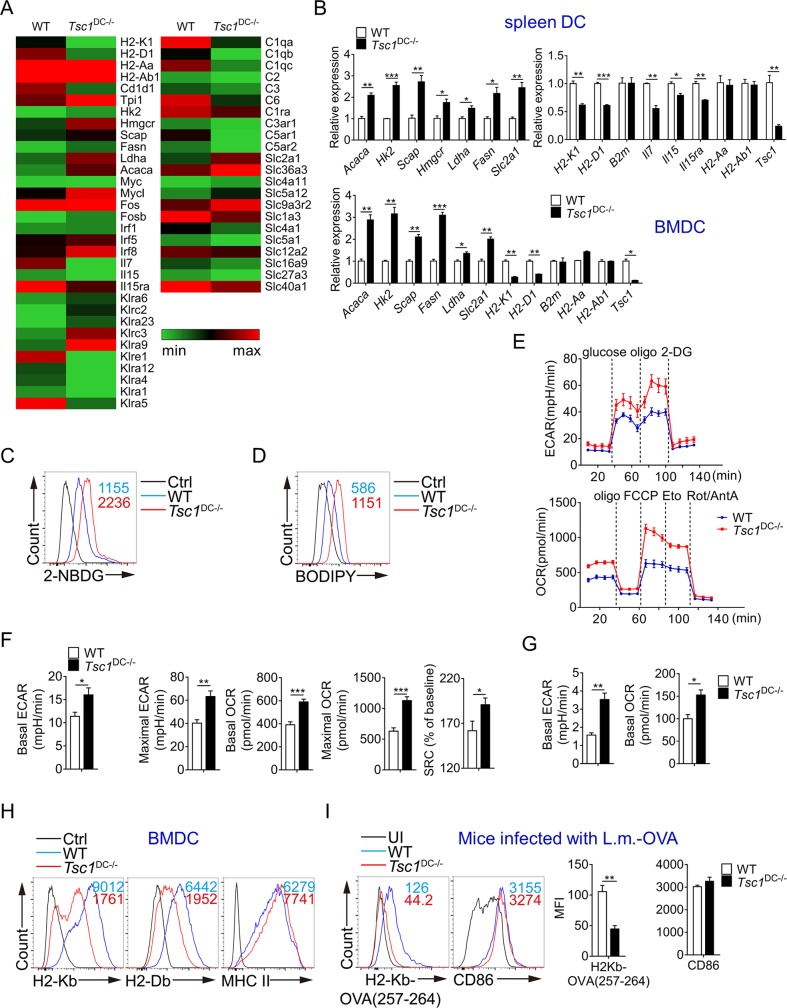
Elevated glycolysis and fatty acid synthesis in TSC1DC-KO mice.(A) Genome-wide RNA-seq analysis on spleen DCs isolated from 6–8-week-old WT and TSC1DC-KO littermates; the heat map shows differentially expressed gene sets, and the original data deposited in the Sequence Read Archive of NCBI database are accessible via accession No. PRJNA516783. (B) Real-time PCR analyses of gene expression in spleen DCs and BMDCs from 6–8-week-old WT and TSC1DC-KO littermates. These experiments were repeated twice with similar results. The data are shown as means ± SEM (*p < 0.05, **p < 0.01, ***p < 0.001; analyzed by Student’s t test). (C and D) BMDCs were incubated with 50 μM 2-NBDG for 15 minutes (C) or 5 μg/ml BODIPY for 30 minutes (D) at 37°C, and the fluorescent intensity was measured by flow cytometry. These experiments were repeated once with similar results. (E and F) Real-time changes in ECAR and OCR were analyzed in WT and TSC1DC-KO BMDCs by a Seahorse analyzer following sequential treatment with 10 mM glucose, 1 μM oligo, and 100 mM 2-DG or with 1 μM oligo, 1.5 μM FCCP, 200 μM Eto, and 100 nM Rot plus 1 μM AntA (Rot/AntA). Basal ECAR, maximal ECAR (after treatment with oligo), basal OCR, maximal OCR (after treatment with FCCP), and SRC were calculated accordingly (F). These experiments were repeated twice with similar results. The data are shown as means ± SEM (*p < 0.05, **p < 0.01, ***p < 0.001; analyzed by Student’s t test). (G) The basal ECAR and OCR of splenic DCs from WT and TSC1DC-KO mice were analyzed by a Seahorse analyzer, and this experiment was conducted twice with similar results. The data are presented as means ± SEM (*p < 0.05, **p < 0.01; analyzed by Student’s t test). (H) The cell surface MHC-I and MHC-II expression in WT and TSC1DC-KO BMDCs was analyzed by flow cytometry. This experiment was repeated once with similar results. (I) The 6–8-week-old WT and TSC1DC-KO littermates (n = 3) were i.v. infected with 105 CFU of L.M.-OVA, and the expression levels of cell surface H2-Kb/OVA257-264 complexes and CD86 in splenic DCs (gated on CD11c+MHC-II+) were analyzed by flow cytometry after 3 days. This experiment was repeated once with similar results. MFI are presented as means ± SEM (**p < 0.01, analyzed by Student’s t test). Underlying data are available in S1 Data. 2-DG, 2-deoxy-D-glucose; 2-NBDG, 2-deoxy-2-[(7-nitro-2,1,3-benzoxadiazol-4-yl)amino]-D-glucose; Acaca, acetyl-coenzyme A carboxylase alpha; AntA, antimycin A; B2m, beta-2 microglobulin; BMDC, bone marrow–derived DC; BODIPY, boron-dipyrromethene; CD, cluster of differentiation; CFU, colony-forming unit; Ctrl, control; DC, dendritic cell; ECAR, extracellular acidification rate; Eto, etomoxir; Fasn, fatty acid synthase; FCCP, fluoro-carbonyl cyanide phenylhydrazone; H2-Aa, histocompatibility 2, class II antigen A, alpha; H2-Ab1, histocompatibility 2, class II antigen A, beta 1; H2-Db, histocompatibility 2, D region locus 1; H2-Kb, histocompatibility 2, K1, K region; Hk2, hexokinase 2; Hmgcr, 3-hydroxy-3-methylglutaryl-coenzyme A reductase; Il, interleukin; Ldha, lactate dehydrogenase A; L.M., L. monocytogenes; MFI, mean fluorescence intensity; MHC, major histocompatibility complex; NCBI, National Center for Biotechnology Information; OCR, oxygen consumption rate; oligo, oligomycin; OVA, ovalbumin; RNA-seq, RNA sequencing; Rot, rotenone; Scap, sterol regulatory element binding transcription factor chaperone; Slc2a1, solute carrier family 2 member 1; SRC, spare respiratory capacity; Tsc1, tuberous sclerosis complex subunit 1; TSC1DC-KO, specific ablation of Tsc1 in the DC compartment; UI, uninfected; WT, wild-type.